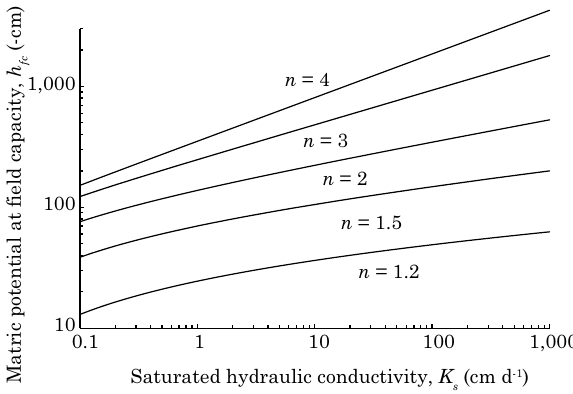
Figure 3. Matric potential corresponding to field capacity ( h fc ) as a function of saturated hydraulic conductivity ( K s ), according to Twarakavi et al. (2009) (Equation 6) considering a negligible bottom flux for the purpose of field capacity ( q fc ) of 0.01 cm d -1 , for five van Genuchten (1980) soils (five values of shape factor n ; shape factor α equal to 0.015 cm -1 in all